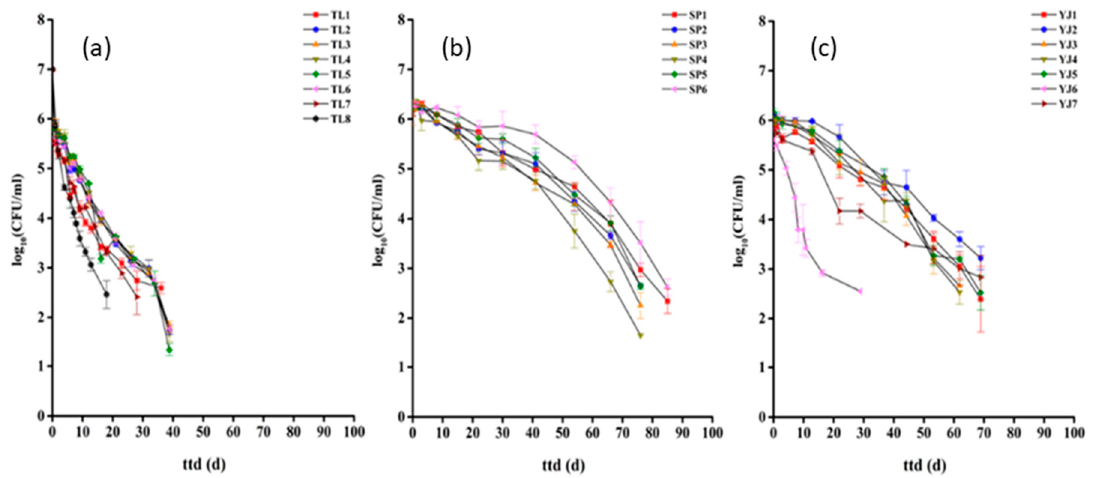
Figure 3. Survival profiles of E. coli O157:H7 in soils from di ff erent sampling sites. TL ( a ), SP ( b ), and YJ ( c ) indicate that the soil samples were collected from Tongliao, Siping, and Yanji, respectively. Standard errors were means of triplicate